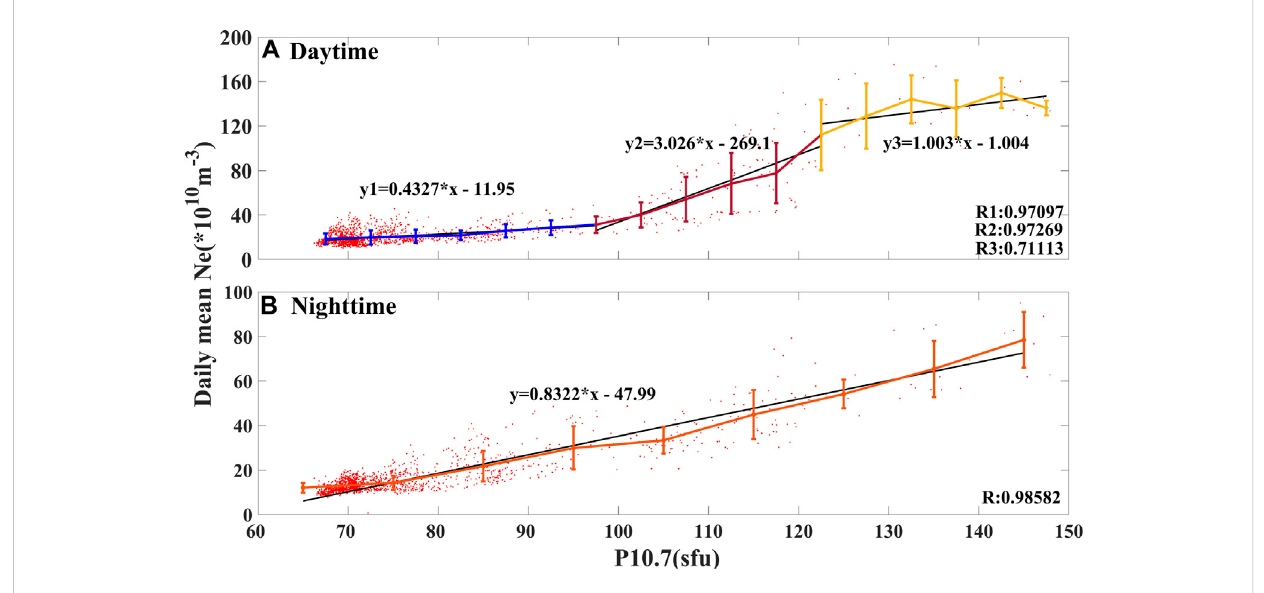
FIGURE 2 The distribution of Ne with P10.7 at daytime (A) and nighttime (B) .